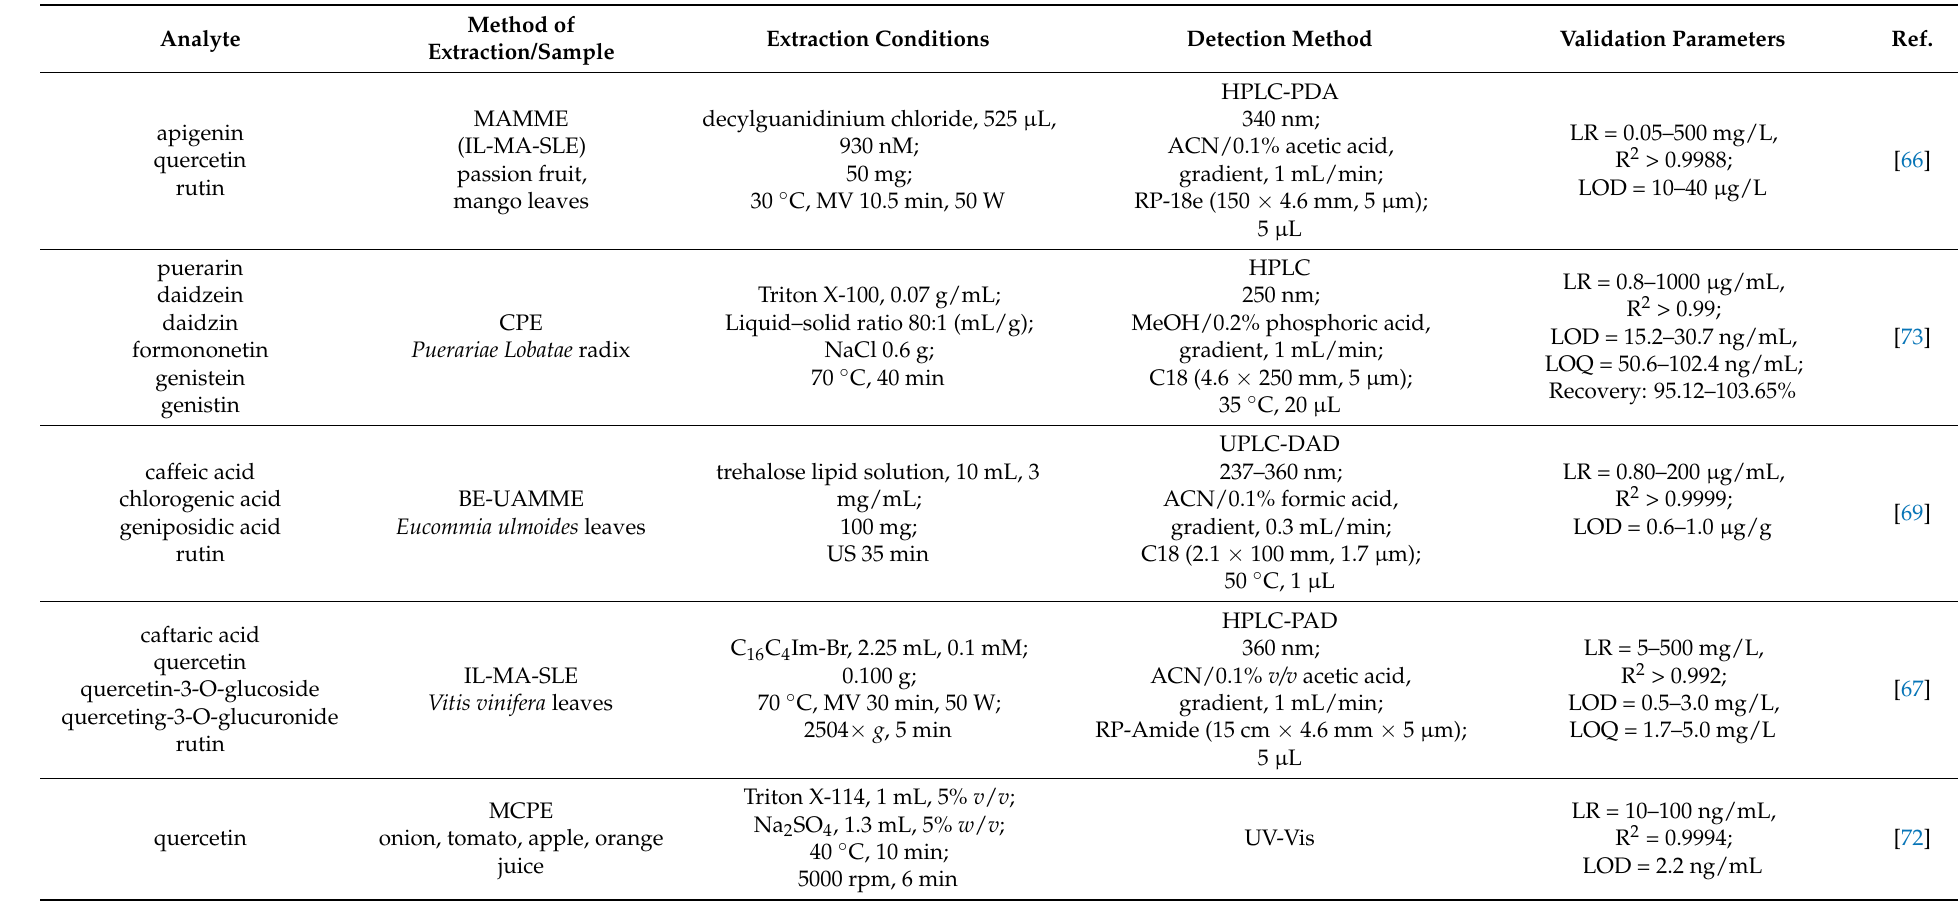
Table 2. Characteristics of surfactant-assisted extraction techniques used for determination of